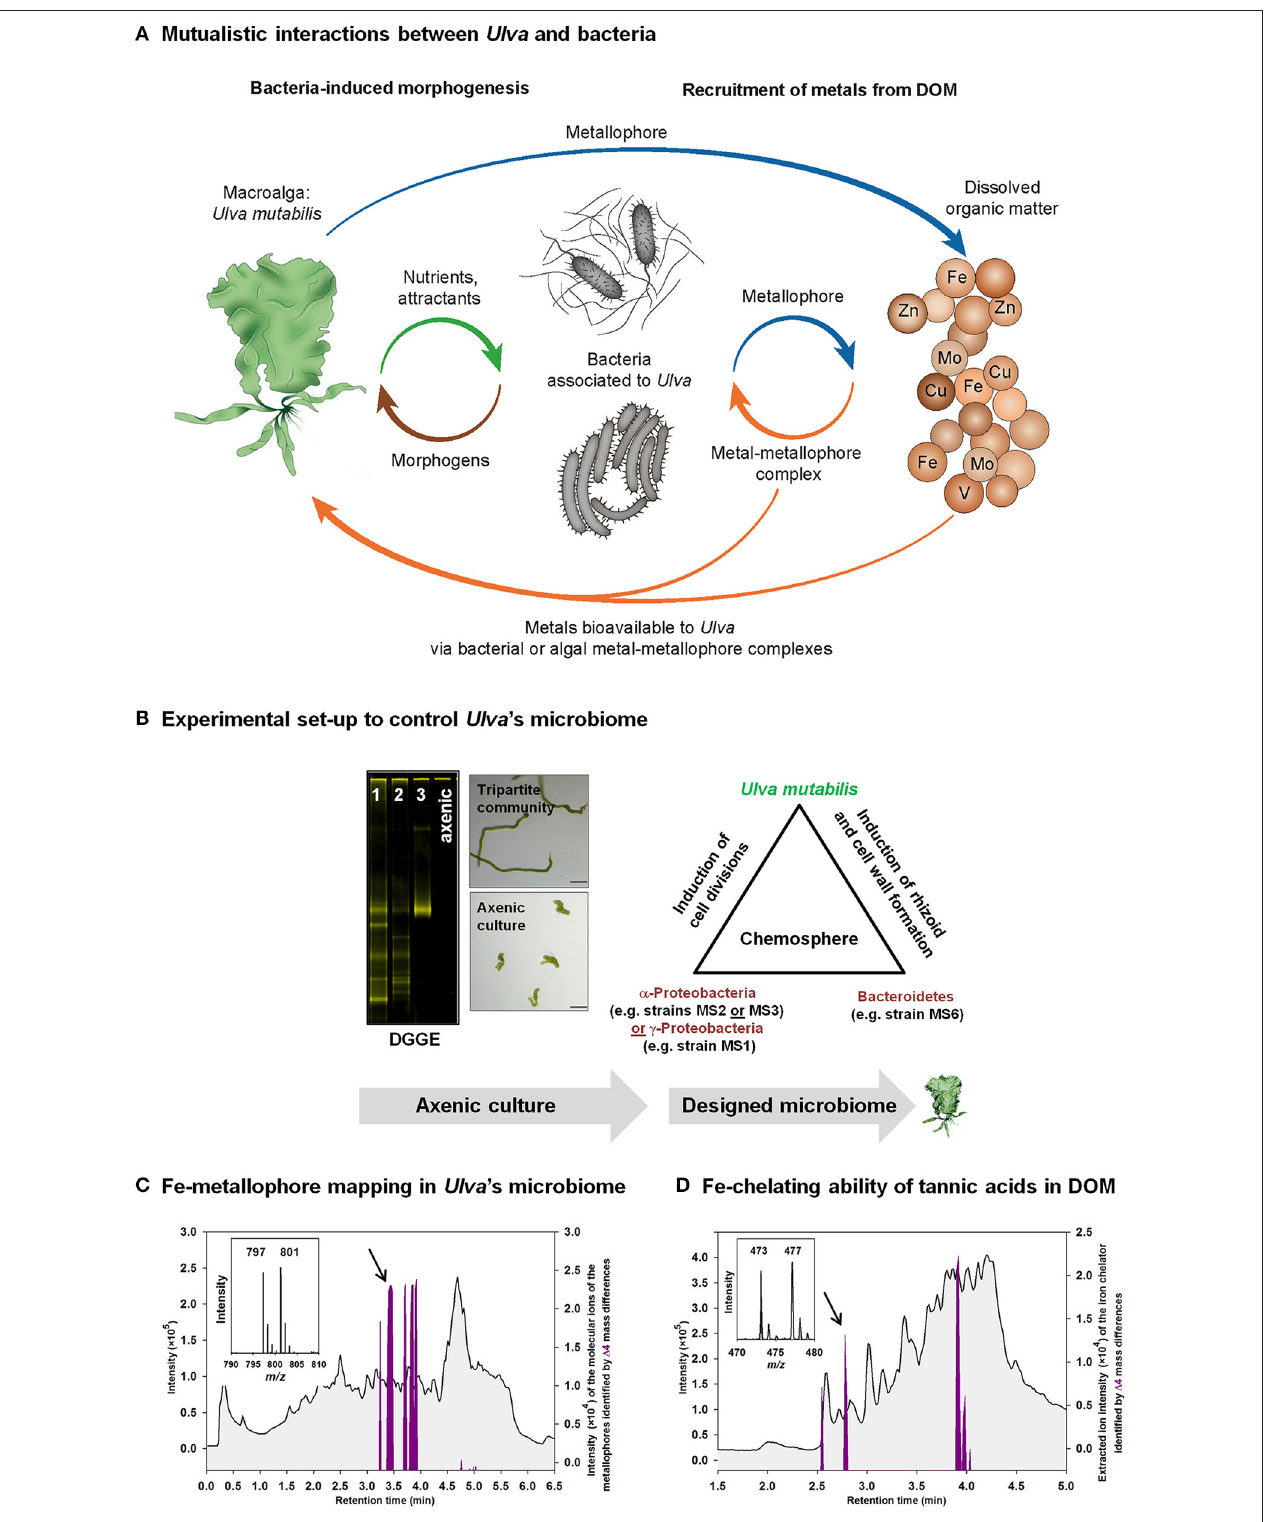
FIGURE 2 | Studying metal acquisitions in Ulva ’s chemosphere. (A) Mutualistic interactions are vital for Ulva and bacteria by releasing morphogens, nutrients, and attractants, and by controlling the metal acquisition by ligand exchange processes (strategy II) from particulate or dissolved metal-organic matter complexes within the chemosphere. (B) Axenic cultures of Ulva have to be established to achieve reproducible and repeatable conditions for laboratory studies. These conditions